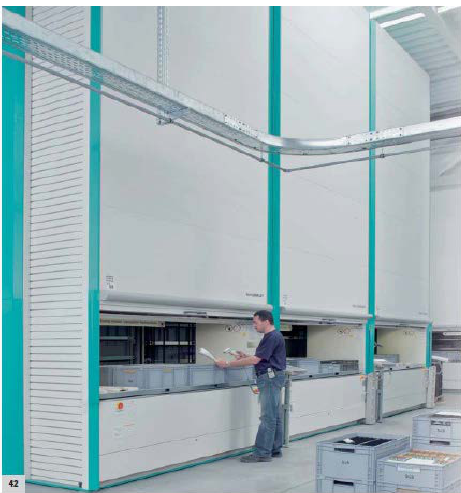
Figure 1. Vertical lift storage.